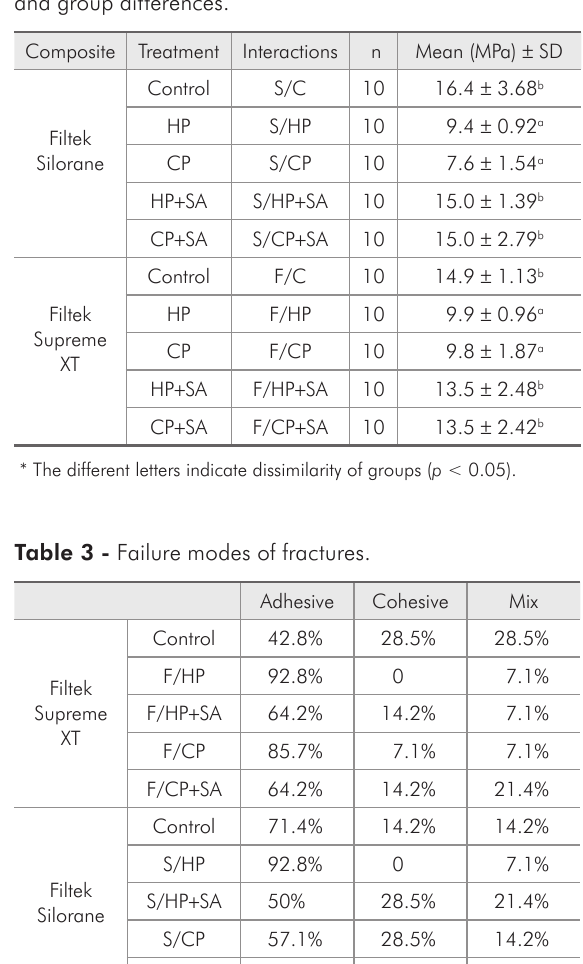
Table 2 - Mean bond strengths (MPa), standard deviation and group differences. Composite Treatment Interactions